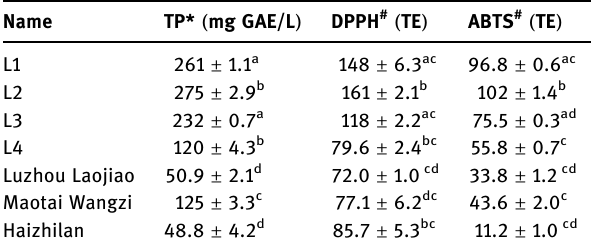
Table 2: Total phenolic content and antioxidant activity of four functional liquors and three typical white